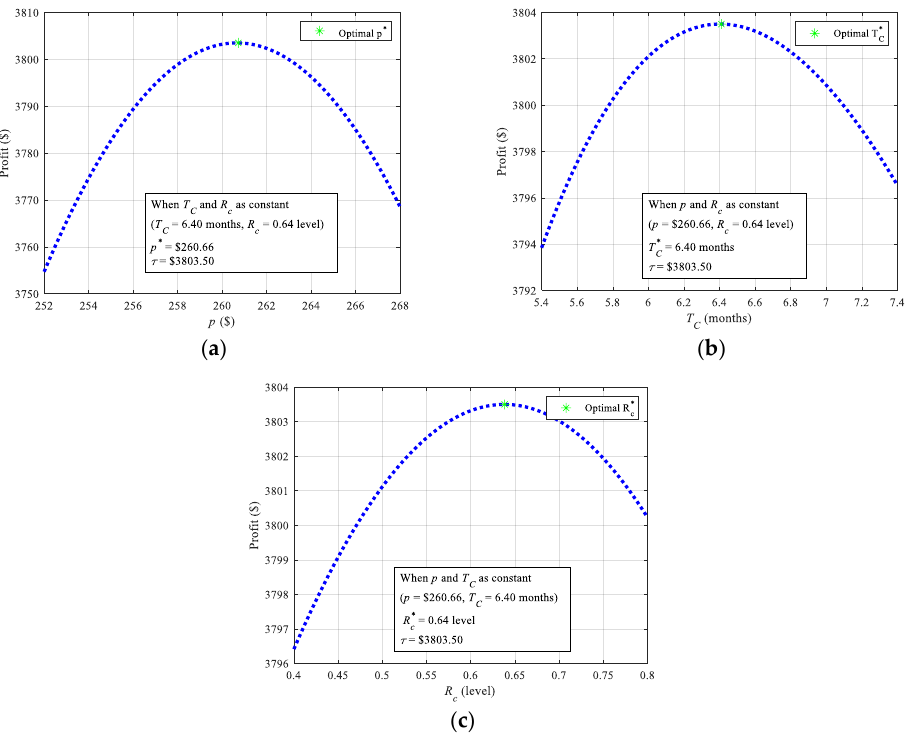
Figure 6. Profit function ( τ ) regarding ( a ) the selling price ( p ); ( b ) cycle time ( T C ); ( c ) manufacturer’s carbon emission reduction level ( R c